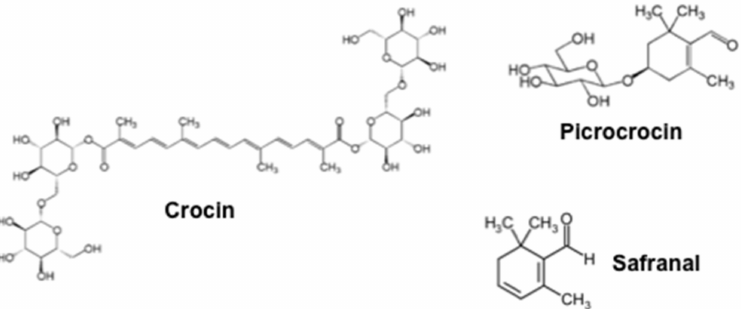
Figure 2. The three main biologically active compounds of sa ff